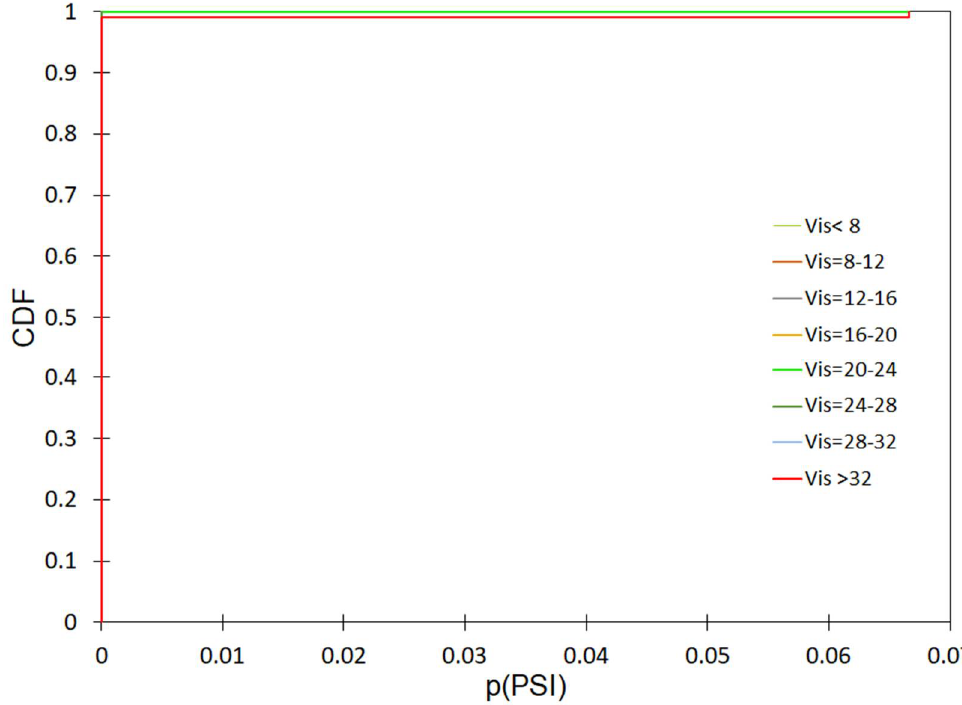
Figure A19. Effect of visibility on the incidence of high summer mortality for dry days.